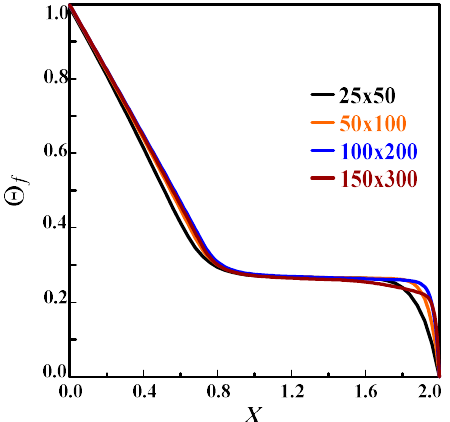
Figure 5. Grid test of the dimensionless fluid temperature ( f ) profiles at Y=0.5 with Pr = 50, Kr = 10 + 3 , Rc = 1, Da = 10 − 3 , Ec = 0, ε = 0.7, ω = 10 PPI, Re =